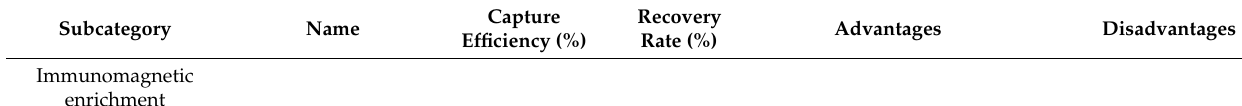
Table 1. CTC isolation technologies, grouped based on enrichment method. Capture efficiency, recovery rate and advantages and disadvantages of the technologies are also